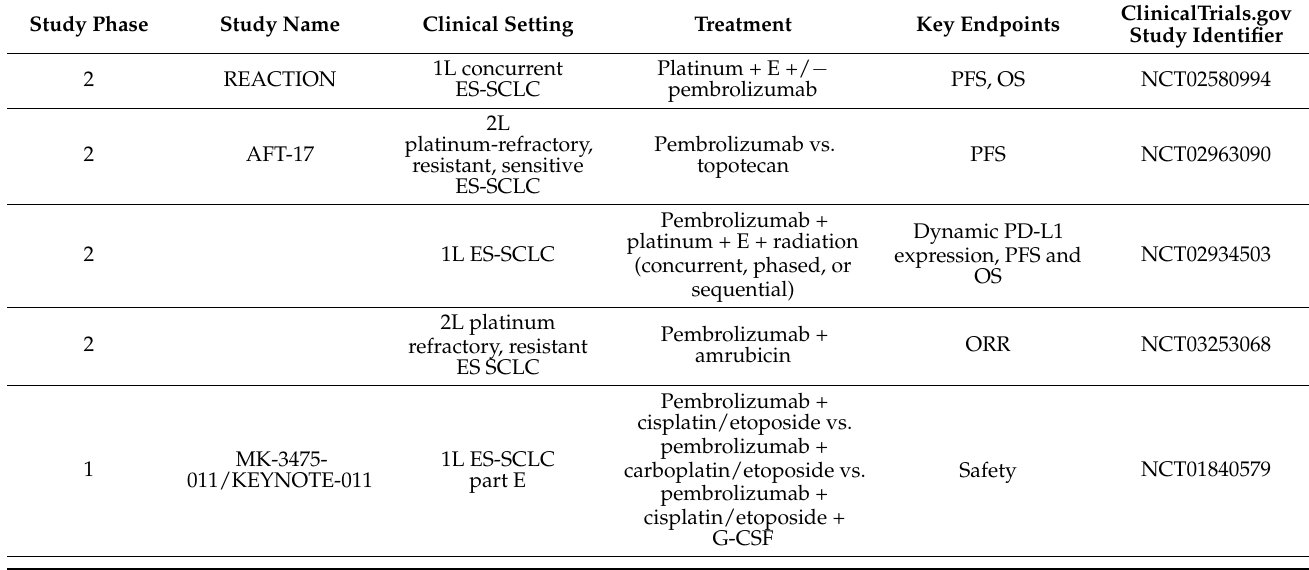
Table 4. Select ongoing pembrolizumab trials in small-cell lung